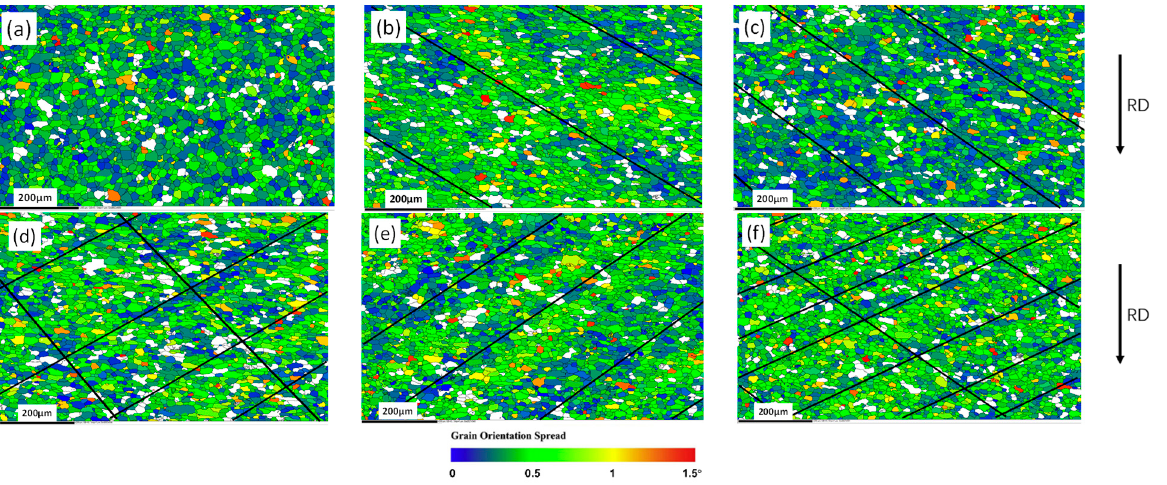
Figure 10. EBSD grain-orientation-spread maps (0–1.5 ◦ ) showing the strain bands in temper-rolled CA low-carbon strip with temper-rolling reductions ( a ) 0%; ( b ) 0.2%; ( c ) 0.4%; ( d ) 0.8%; ( e ) 1.6%; ( f )